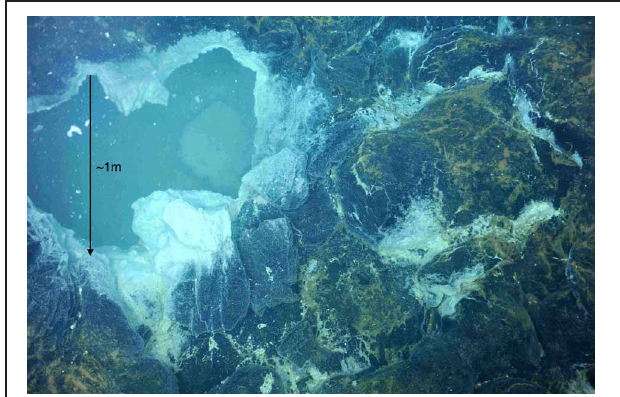
FIGURE 1 | Seafloor photograph of the “Subway” snowblower vent, Axial Seamount, Juan de Fuca Ridge, showing white flocculent “snow” inside the venting orifice and orange floc coating the surroundingseafloor. White floc samples 1 and 2 were collected here, while orange floc was collected further away from the venting